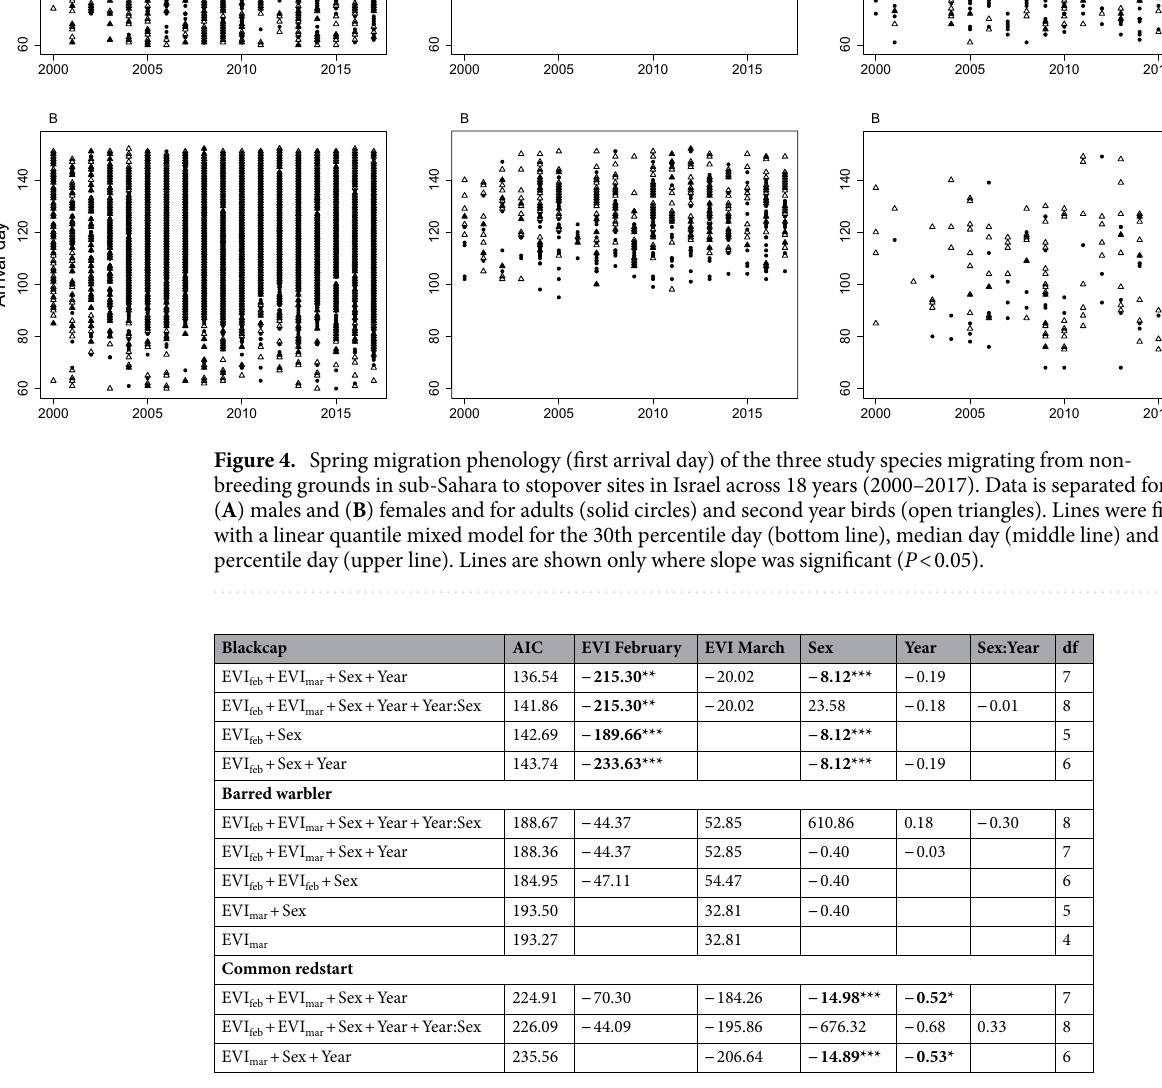
Table 4. Summary of models testing the effect of EVI on arrival timing. Model selection and slopes for each variable in a general linear mixed effect model (GLMM) to describe the relationship between mean arrival day and Enhanced Vegetation Index (EVI) at the species-specific non-breeding grounds during the years 2000– 2017 in the months prior to migration departure (February and March) in the three study species. Best models appear in the first line. We started with the most complicated models (i.e. including all variables) and excluded variables based on significance level set to P = 0.05. Significance code: . 0.06, * < 0.05, ** < 0.01, *** < 0.001.